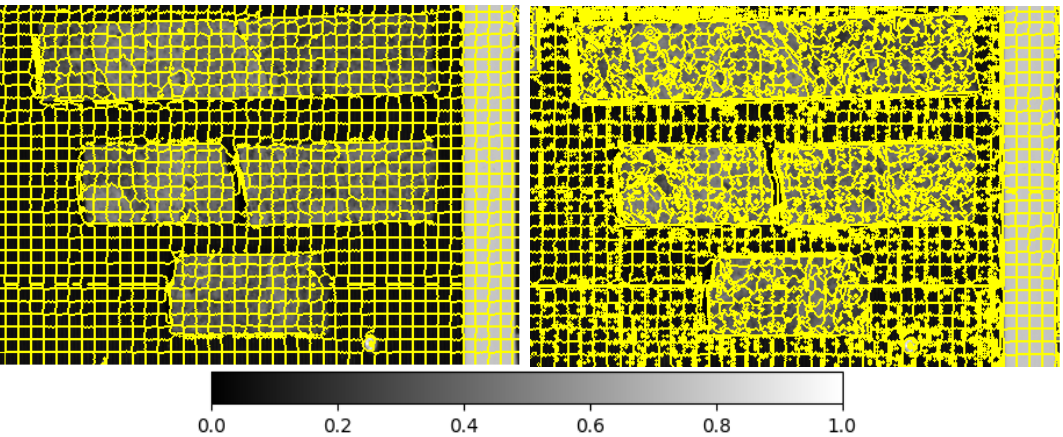
Figure 7. HySSIC applied to samples with spatial structures that must be preserved. Left : prioritizing spatial cohesion. Right : increasing relevance of spectral content. Colormap: the colors black and gray describe background and objects in the image respectively; yellow lines describe the boundaries of the